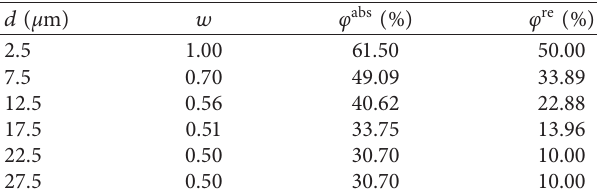
Table 4: Local water-cement ratio and local porosity of